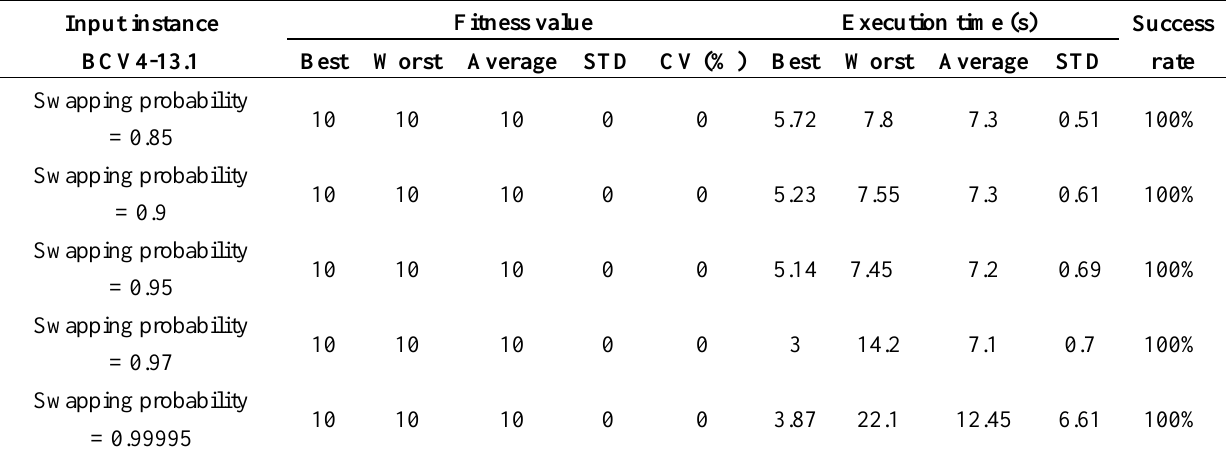
Table 19. Investigating the effect of swapping probability for input instance,